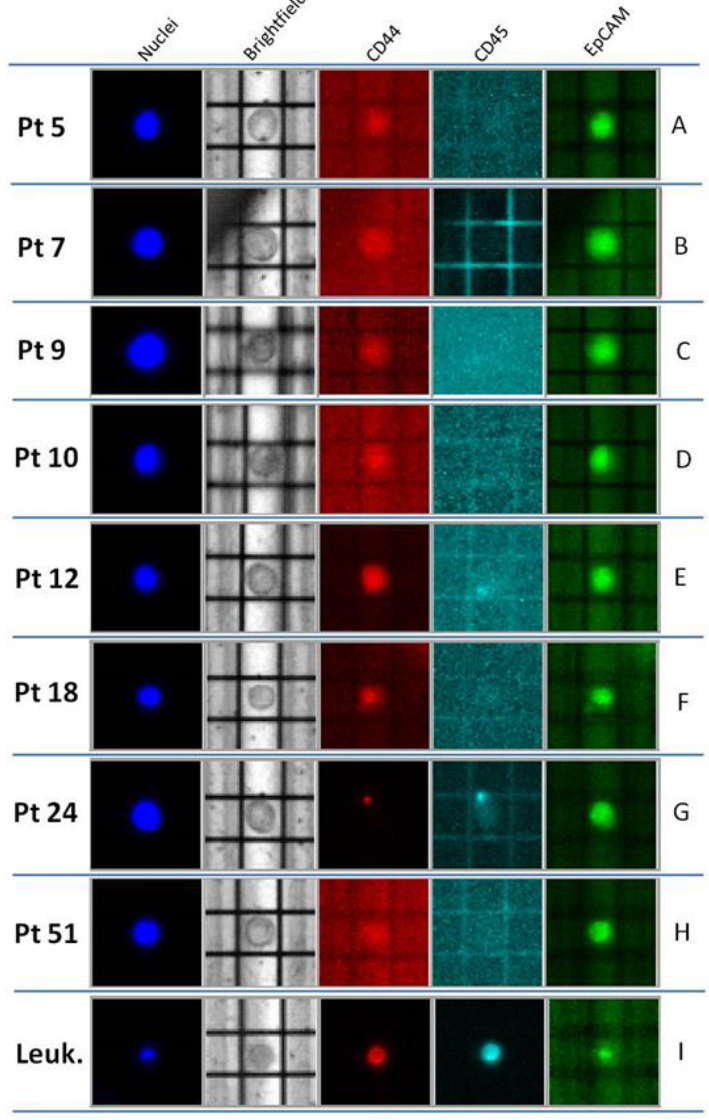
Figure 4. Representative Circulating Tumor Cells (CTCs) recovered from breast cancer (BC) patients on DEPArray TM . CTCs ( A – H ) are identified as round, middle-sized cells, which are Hoechst and EpCAM-positive and CD45 negative. A low CD44 expression is appreciated only in Pt. 12. In ( G ), the CD45 fluorescent dot may represent a non-nuclear component of blood (i.e., erythrocyte or platelet). Leukocyte in ( I ) is CD44- and CD45-positive.